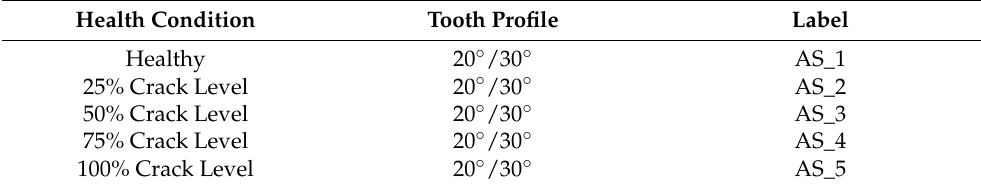
Table 6. The classes identified for 20 ◦ /30 ◦ profiled asymmetric spur gears. Health Condition Tooth Profile